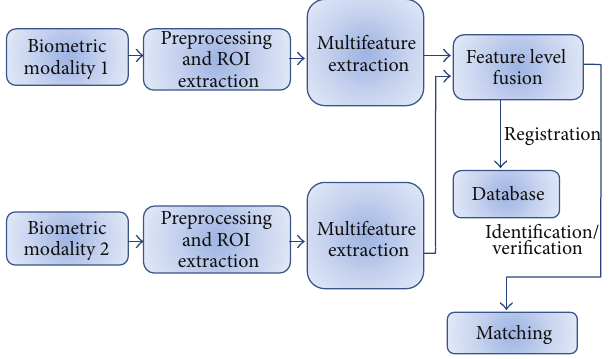
Figure 1: Feature fusion using hierarchical multiresolution LBP and